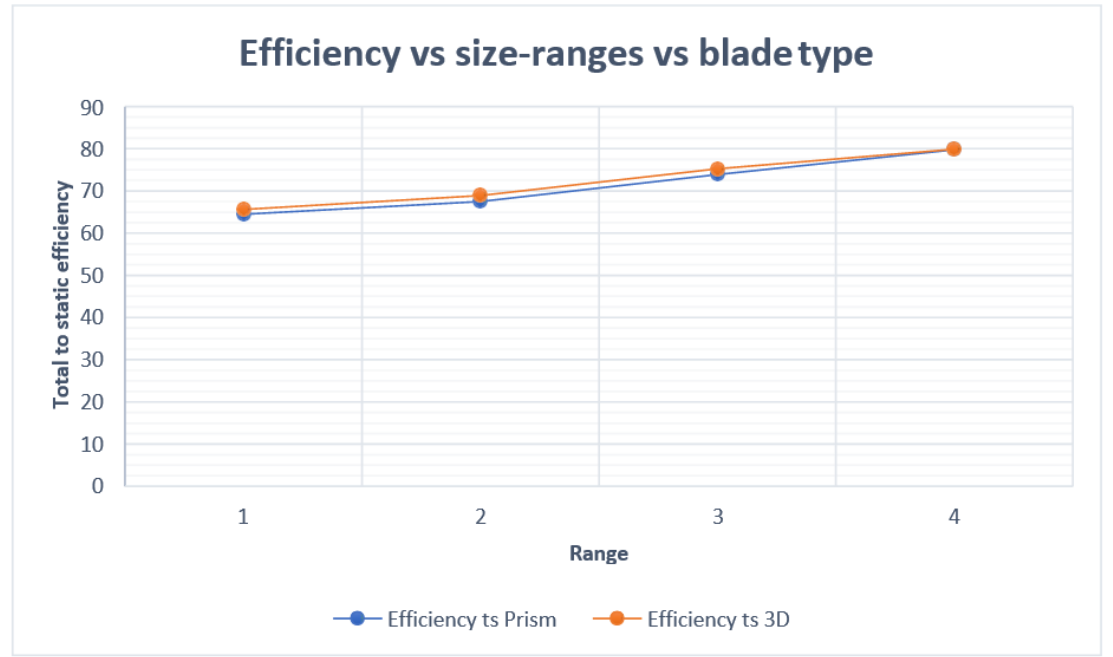
Figure 15. Efficiency vs. size ranges and blade types for low engine revolution turbines. Figure 15. E ffi ciency vs. size ranges and blade types for low engine revolution turbines.